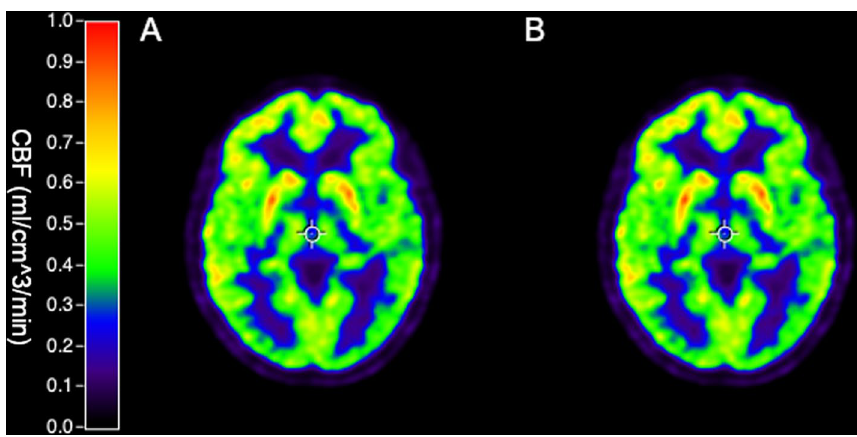
Fig. 7 Parametric images of the CBF derived from IDIF after PVC ( A ) and BSIF derived CBF ( B